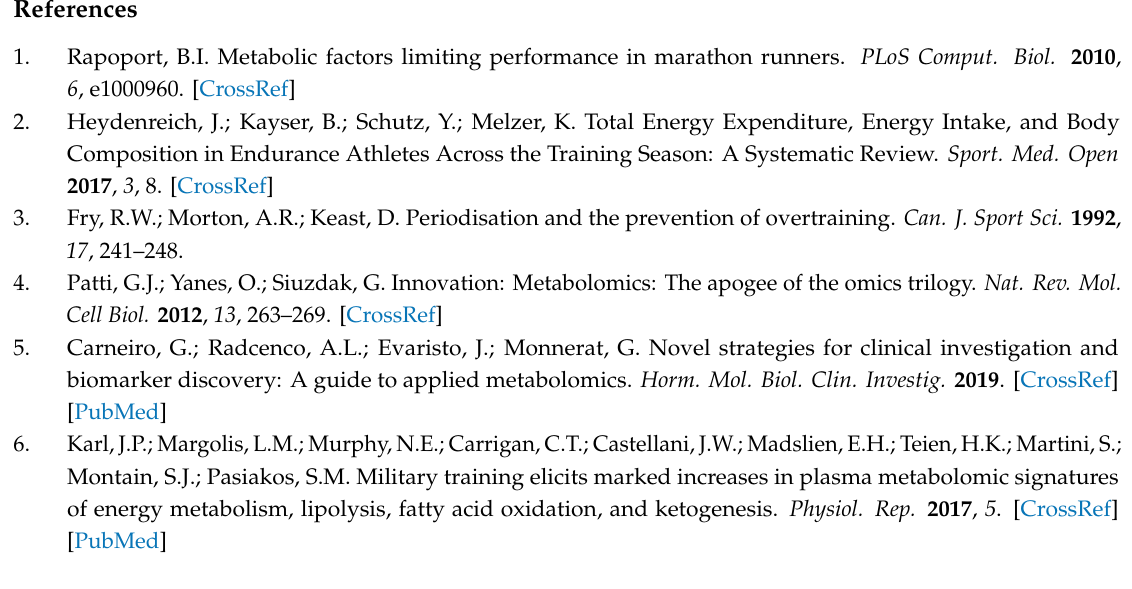
Figure S1: Flow diagram of included study participants, Figure S2: Performer class specific log2-fold changes referenced to time point 1. * p < 0.05, ** p < 0.01, *** p < 0.001, Quantification of 188 metabolites including acylcarnitines, amino acids, biogenic amines, hexoses, phospholipids (lysophosphatidylcholines, phosphatidylcholines), sphingolipids (sphingomyelins), and metabolite sums and ratios. Groups included top ( n = 20, top performers, TP), average ( n = 40, average performers, AP), and low ( n = 20, low performers, LP) performers based on endurance capacity (relative VO 2 max) and net marathon finishing time. Blood samples were collected at time points T1 (training phase), T2 (tapering phase), T3 (immediately after the race), T4 (24 h post-race), and T5 (72 h post-race). All blood samples were measured for the TP and LP groups, with T2, T3, and T4 measured for the AP group, Figure S3: Metabolite concentrations with regard to the di ff erent cohorts. Thirty-three metabolites with significant di ff erences ( p < 0.05) between performer classes. Metabolites / ratios with q-values < 0.05 are denoted as † . 19 metabolites / ratios belong to acylcarnitines, 8 can be attributed to the arginine metabolism. * p < 0.05, ** p < 0.01, *** p < 0.001, NS. Non-significant. (A). Significant di ff erences regarding absolute values at T3 (immediately after the race). Asterisks on the left side denote a significant di ff erence between low and average performers, asterisks in the middle denote a significant di ff erence between low and top performers, and asterisks on the right side denote a significant di ff erence between average and top performers. (B). Significant di ff erences regarding changes from T1 to T3. Significance levels refer to the di ff erences from T1 to T3 within each performer group, Table S1: Metabolites with significantly di ff erent ( p < 0.05) log2-fold changes of T1 normalized time points within the performer classes, Table S2: Metabolites with significantly di ff erent ( p < 0.05) log2-fold changes of T1 normalized time points between the performer